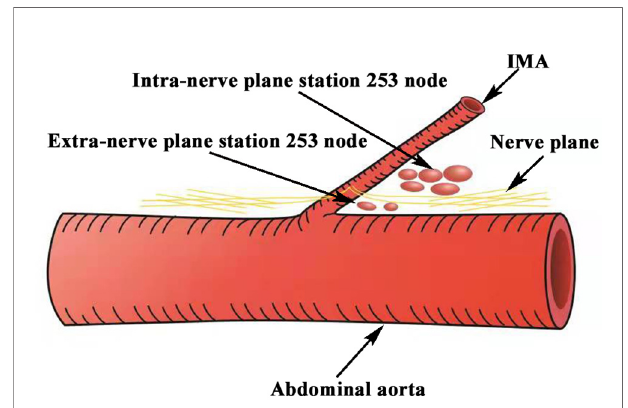
FIGURE 1 | Schematic representation of the extra- and intra-nerve plane station 253 nodes. Station 253 nodes were divided into the extra- and intra- nerve plane station 253 nodes by the IMP nerve plane. IMA, inferior mesenteric artery; IMP, inferior